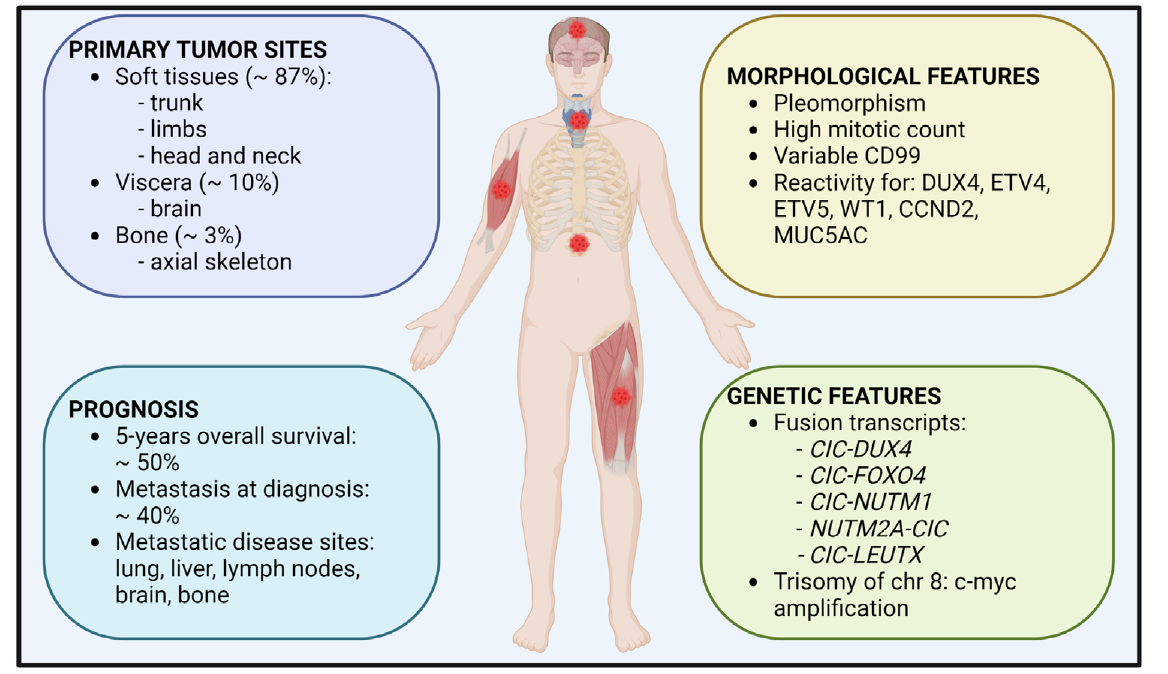
Figure 1. Clinical features of CIC-rearranged sarcomas. The sites of primary localization, prognosis information, along with morphological and genetic features are shown.